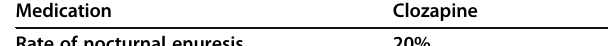
Table 1 Incidence of enuresis in varying antipsychotics